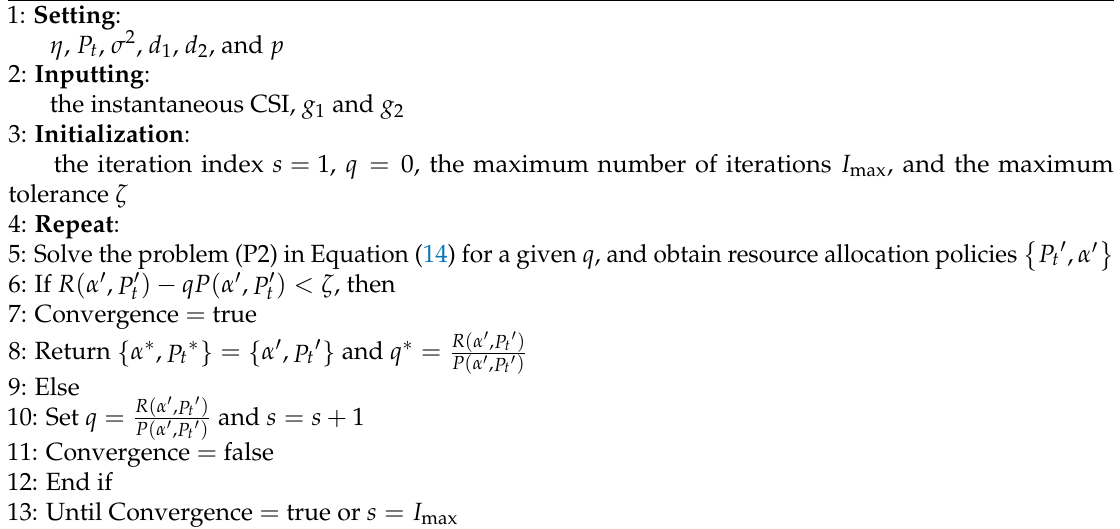
Algorithm 1 The proposed Dinkelbach based iteration algorithm to maximize EE.